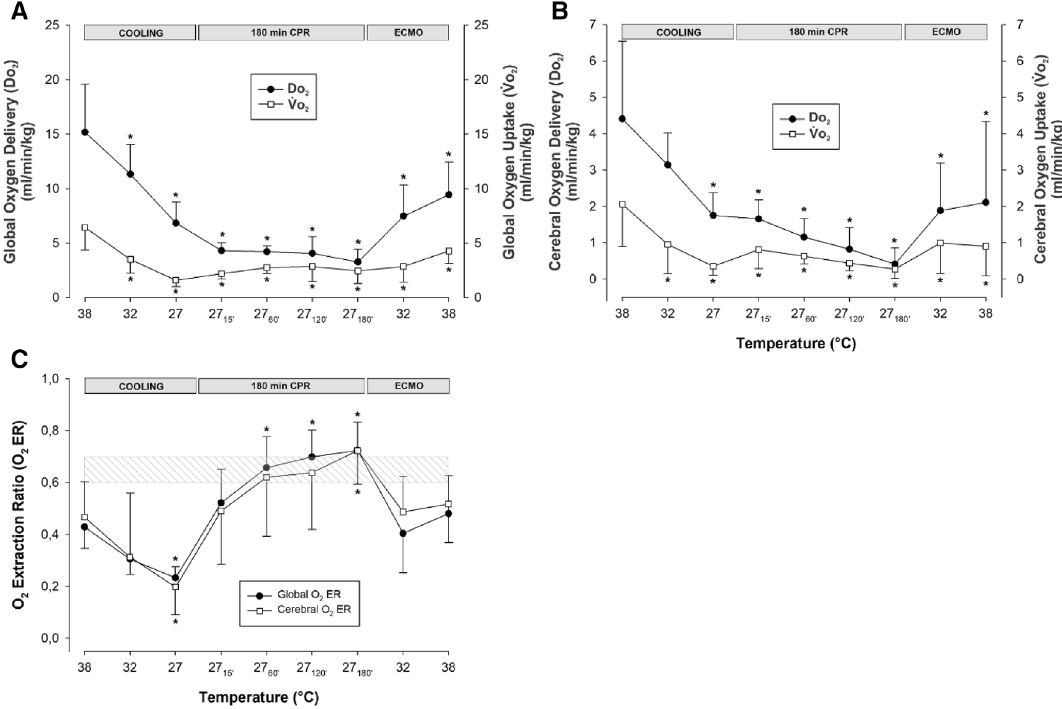
Figure 2. Global and cerebral oxygen delivery, uptake and oxygen extraction ratio. ( A ) Global oxygen delivery ( Ḋ O 2 ), and global oxygen uptake (V ̇ O 2 ). ( B ) Cerebral Ḋ O 2 , and cerebral V ̇ O 2 . ( C ) Global and cerebral oxygen extraction ratio. n = 8, values are mean ± SD. * p < 0.05 statistically significantly different from baseline value. Striated area indicates critical level of extraction ratio. 38 °C 27